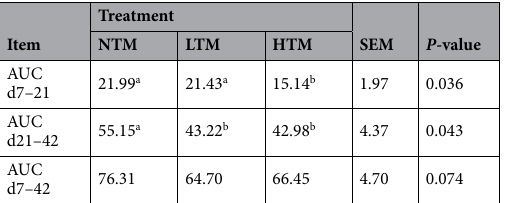
Table 4. Area under the curve (AUC) of footpad lesion scores in broilers fed three supplemental trace mineral levels during d 7 to 21, d 21 to 42, and d 7 to 42 of age. a,b Means within a row with different superscripts differ at P < 0.05. Reported standard error of the mean (SEM) is the average SEM of the individual least-square